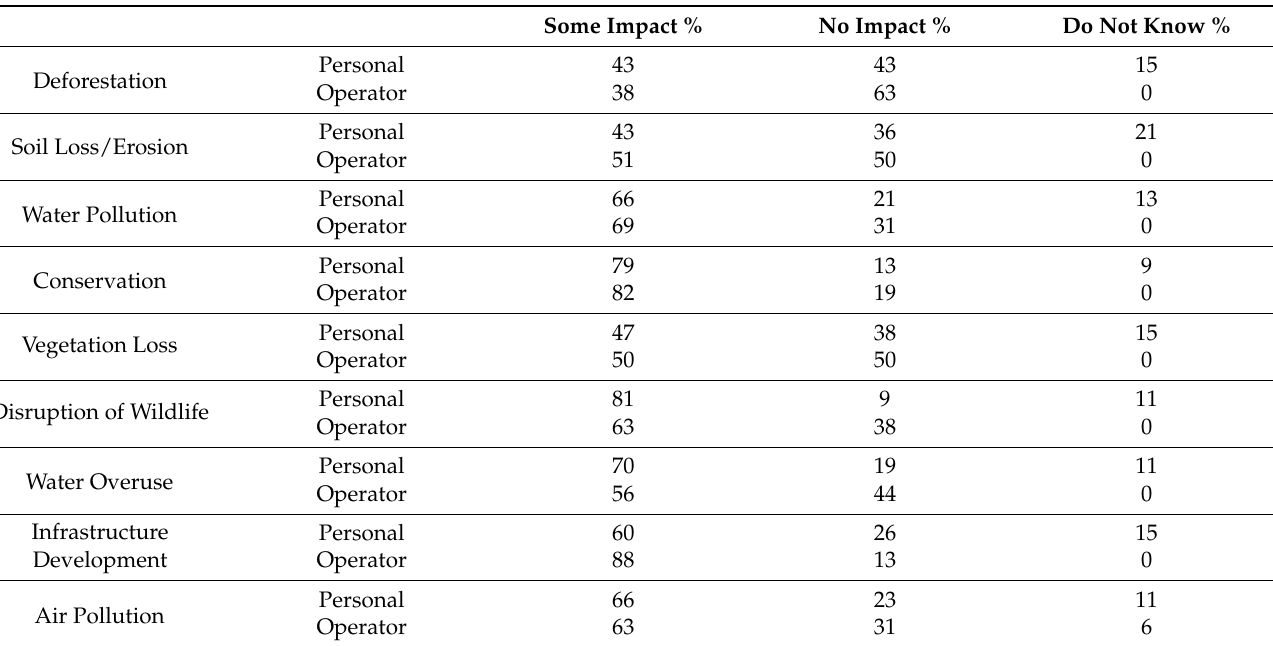
Table 3. Comparison of the perception of tourists’ own impacts on the environment and the perception of tour operators of tourist